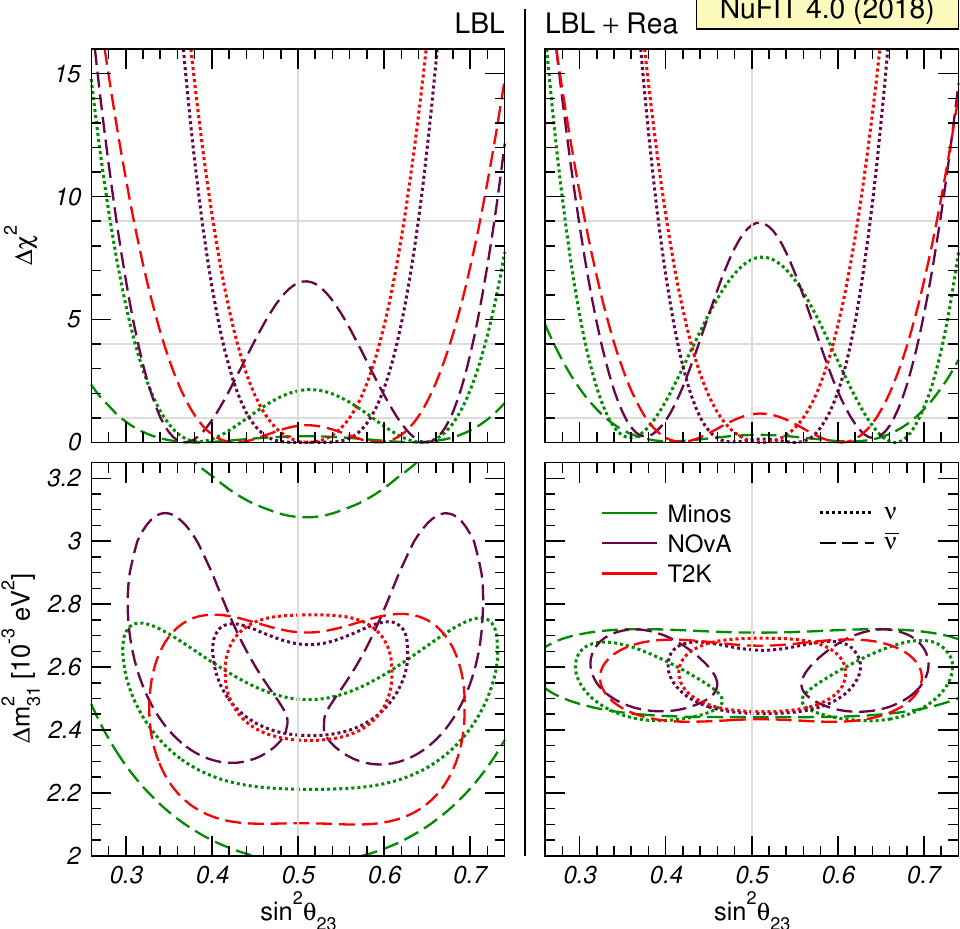
Figure 6 . LBL accelerator (cid:23) (cid:22) disappearance data only, from MINOS, T2K, and NOvA, sepa- rated into neutrino and anti-neutrino data. Left panels correspond to LBL accelerator data with constraint on (cid:18) 13 from the global (cid:12)t (which is dominated by the MBL reactor data) imposed as a Gaussian bias. In the right panels LBL data are consistently combined with MBL reactor data from Daya Bay, RENO, and Double Chooz. Upper panels show the (cid:1) (cid:31) 2 as a function of sin 2 (cid:18) 23 , lower panels show con(cid:12)dence regions at 2 (cid:27) (2 dof). All panels assume NO and (cid:1) m 2 (cid:12)xed to the global best (cid:12)t values. Qualitatively similar behaviour is found in IO.